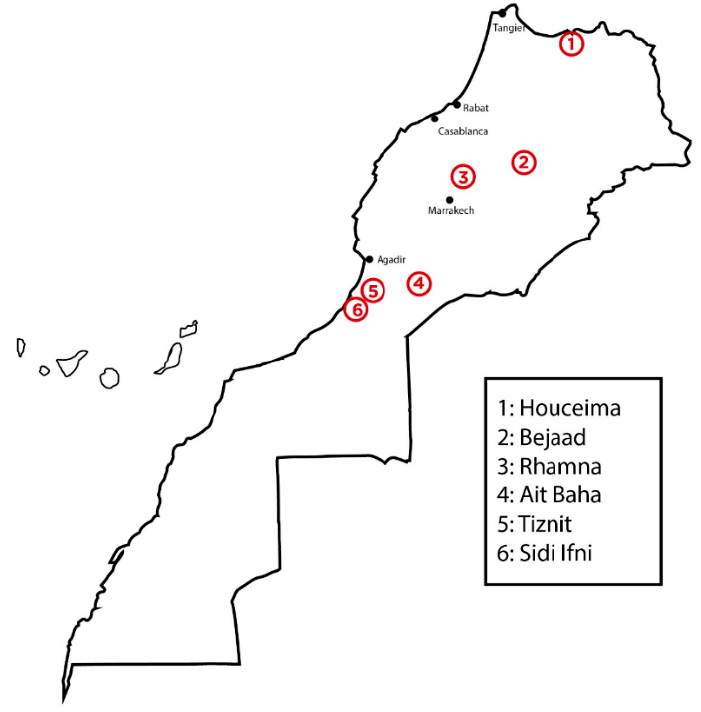
Figure 1. Location of the evaluated cactus seed sites of production in Morocco.